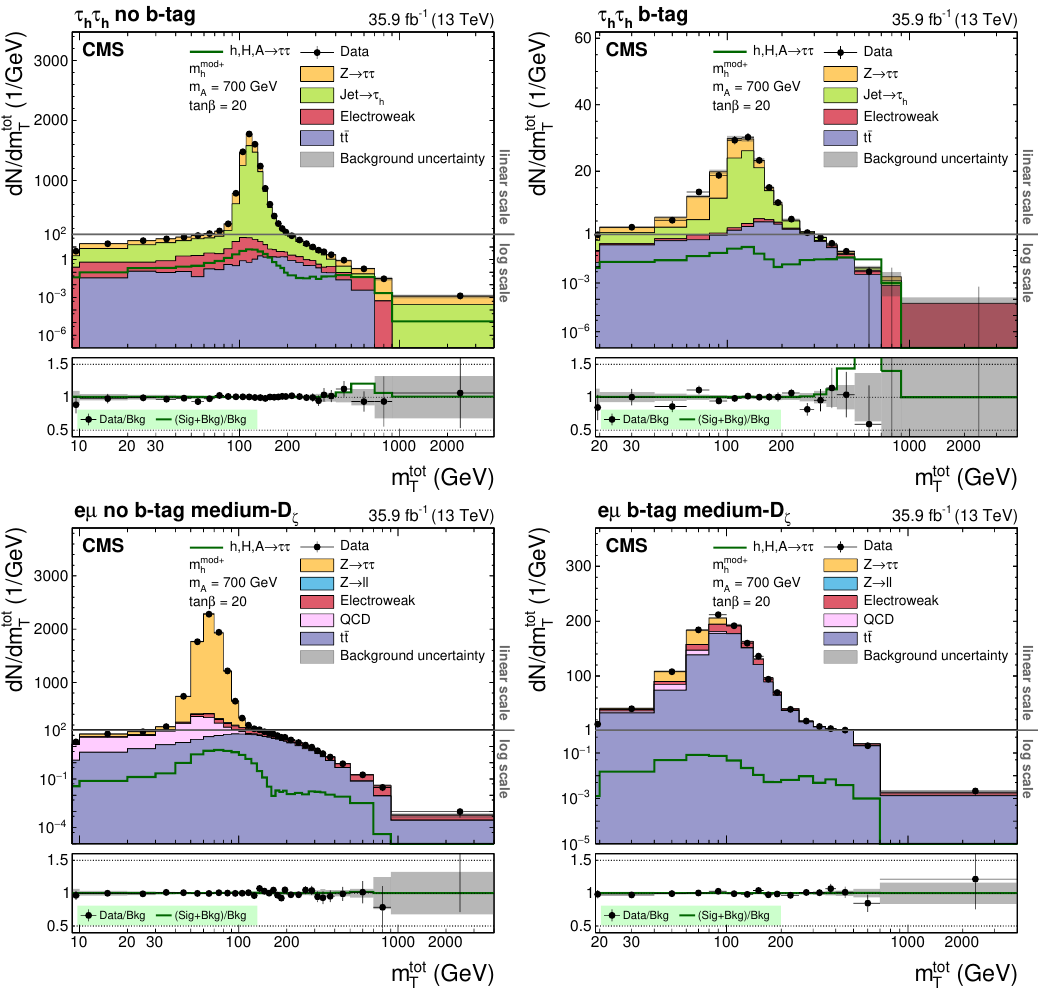
Figure 6 . Distribution of m tot in the global no b-tag (left) and b-tag (right) categories in the (cid:28) h (cid:28) h T (upper row) and e (cid:22) (lower row) (cid:12)nal states. For the e (cid:22) (cid:12)nal state the most sensitive medium- D (cid:16) event subcategory is shown. The gray horizontal line in the upper panel of each sub(cid:12)gure indicates the change from logarithmic to linear scale on the vertical